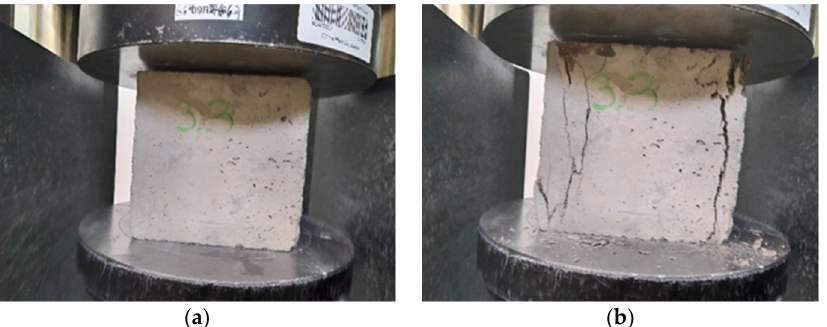
Figure 11. Concrete with ordinary tap water before ( a ) and after compressive strength testing ( b ) following 150 F-T cycles.